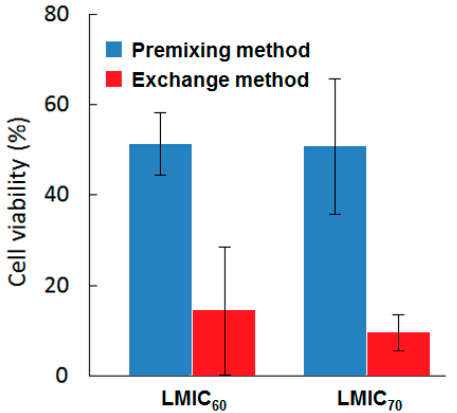
Figure 62. Cell viability following treatment with lipid membrane-incorporated fullerenes LMIC 60 and LMIC 70 , prepared by the exchange and premixing methods, under excitation at 350–500 nm for 2 h in the case of LMIC 60 and 30 min for LMIC 70 ) ([C 60 ] = 2 mM and [C 70 ] = 0.3 mM). Adapted from Ikeda [212].